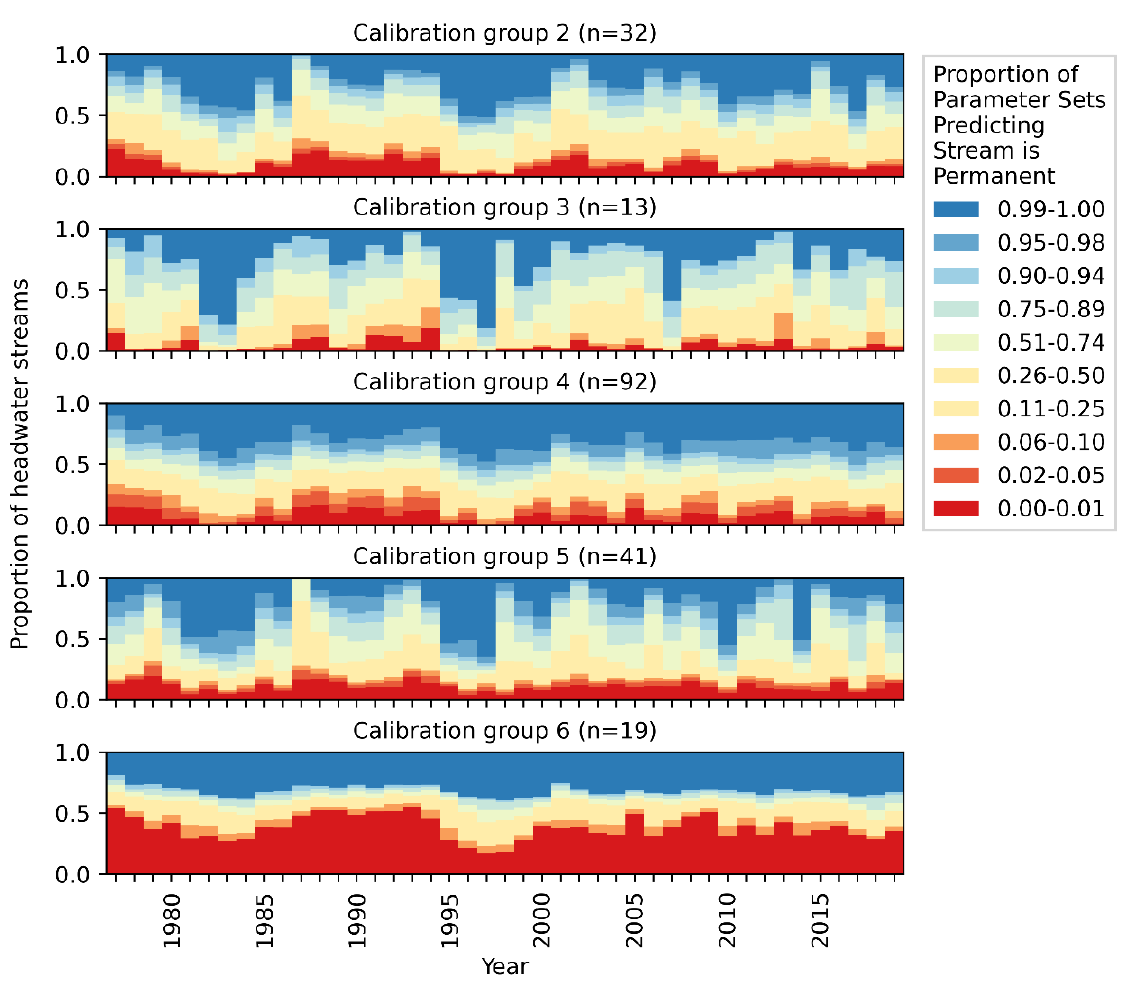
Figure 10. Estimated model precision for each calibration during each year of the study period where n is number of suitable parameter sets tested for each calibration group. Darker blue represents greater precision for a permanent classification and darker red represents greater precision for a non-permanent classification. Yellow indicates stream reaches with a poor precision for the permanence classification.